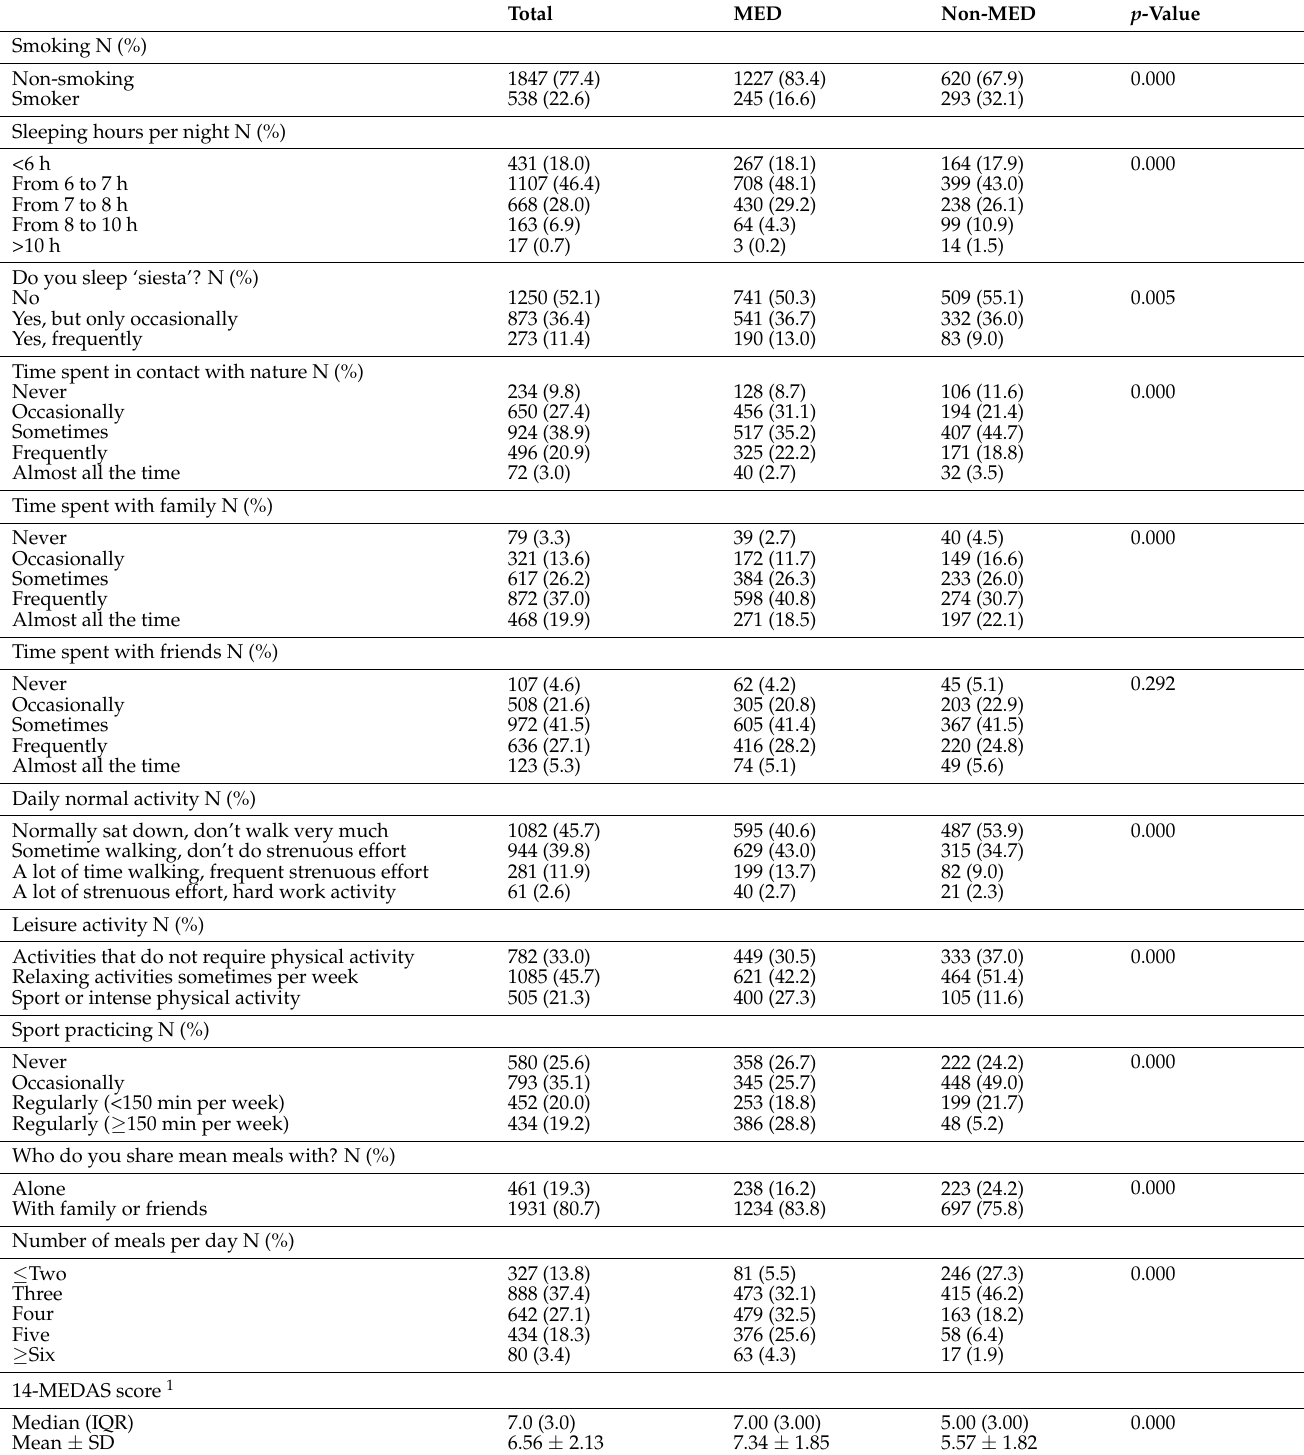
Table 2. Participants’ lifestyle habits: total population, MED and non-MED